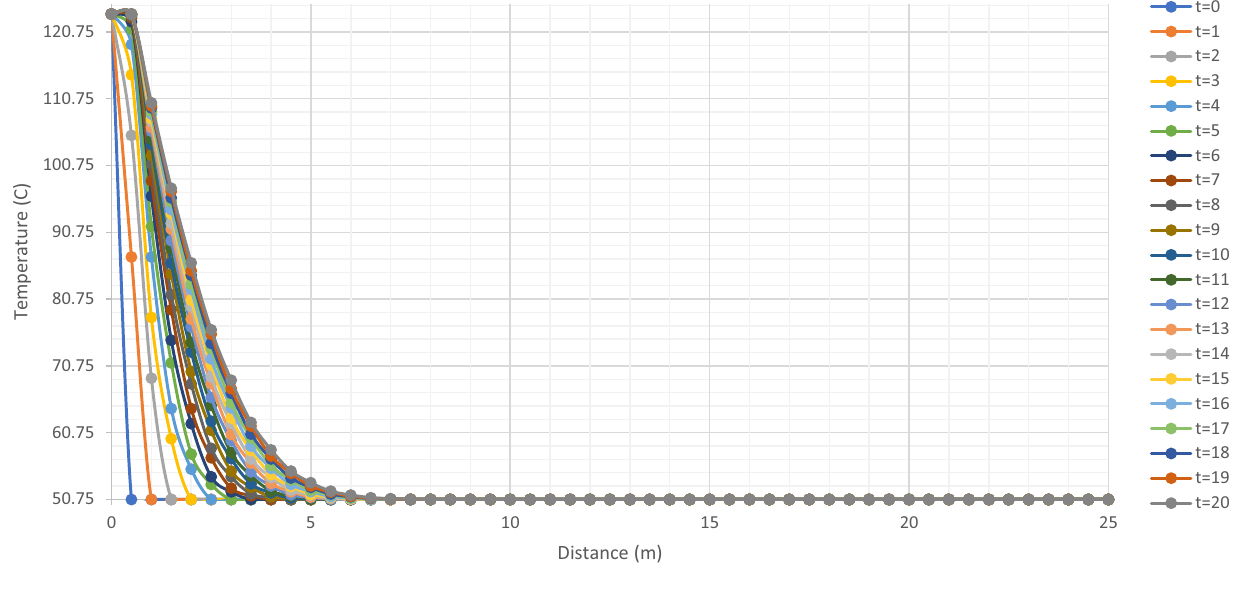
Fig. 9 Numerical result of temperature